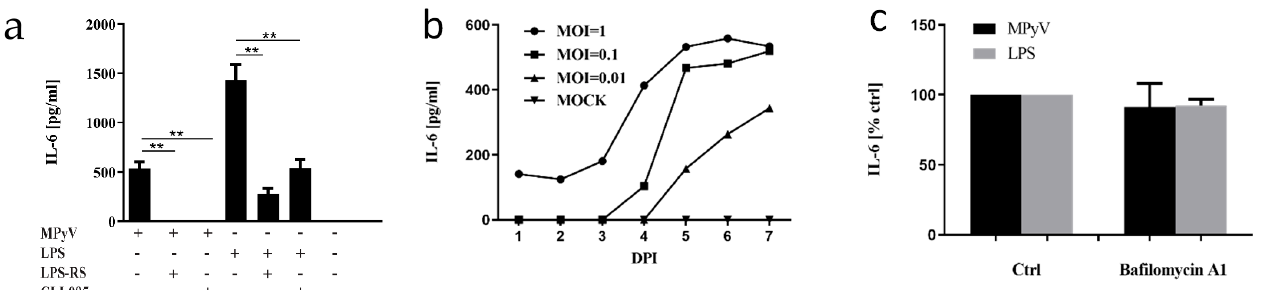
Figure 1. Toll-like receptor 4 (TL4)-mediated recognition of mouse polyomavirus (MPyV) in mouse fibroblasts. ( a ) The production of interleukin (IL)-6 by mouse embryonic fibroblast (MEFs) stimulated with lipopolysaccharide (LPS) or infected with MPyV (multiplicity of infection (MOI) = 5) in the presence of LPS-RS or CLI-095. ( b ) The kinetics of IL-6 secretion by 3T6 cells infected with MPyV with various MOI, 7 days post-infection (DPI). ( c ) The effect of bafilomycin A1 pretreatment on IL-6 secretion by 3T6 cells infected with MPyV (MOI = 5) or stimulated with LPS. ** p < 0.01; two-tailed Mann–Whitney test.